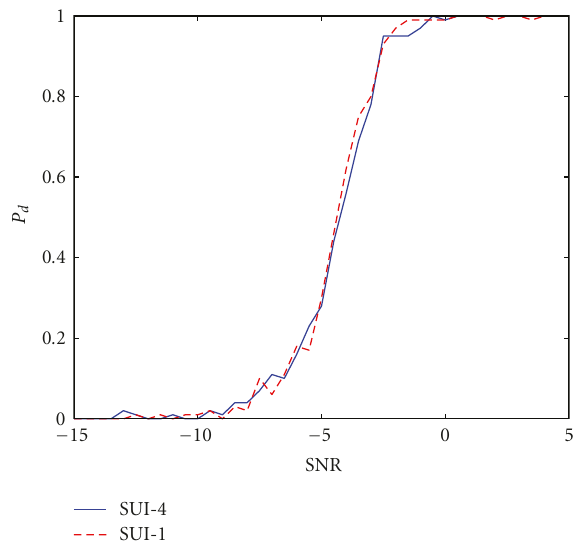
Figure 11: Probability of detection of a ZP-OFDM signal SUI-1&4 channel models with AWGN.